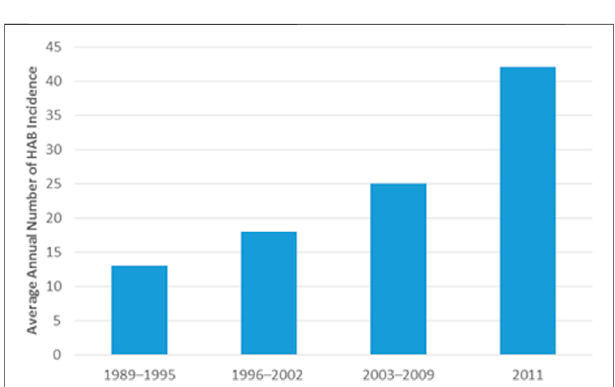
FIGURE 3 | Incidence of harmful algal blooms reported in Kansas (1989 – 2011) (data from Trevino-Garrison et al., 2015).